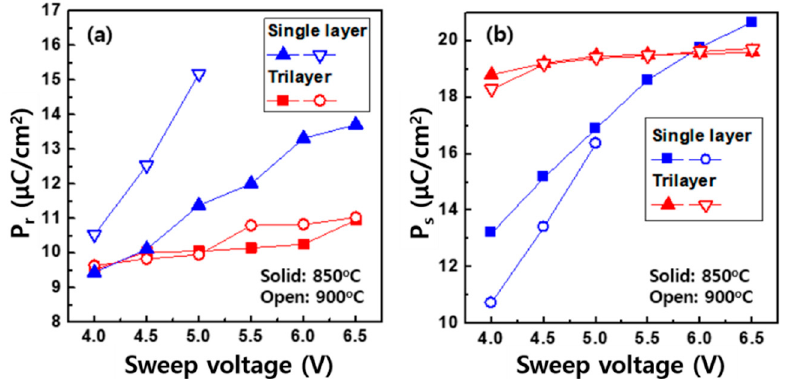
Figure 5. ( a ) P r and ( b ) P s measured at 0 V and 4 V, respectively, as a function of the sweep voltages. The trilayer devices exhibited stable switching parameters over the entire voltage range.